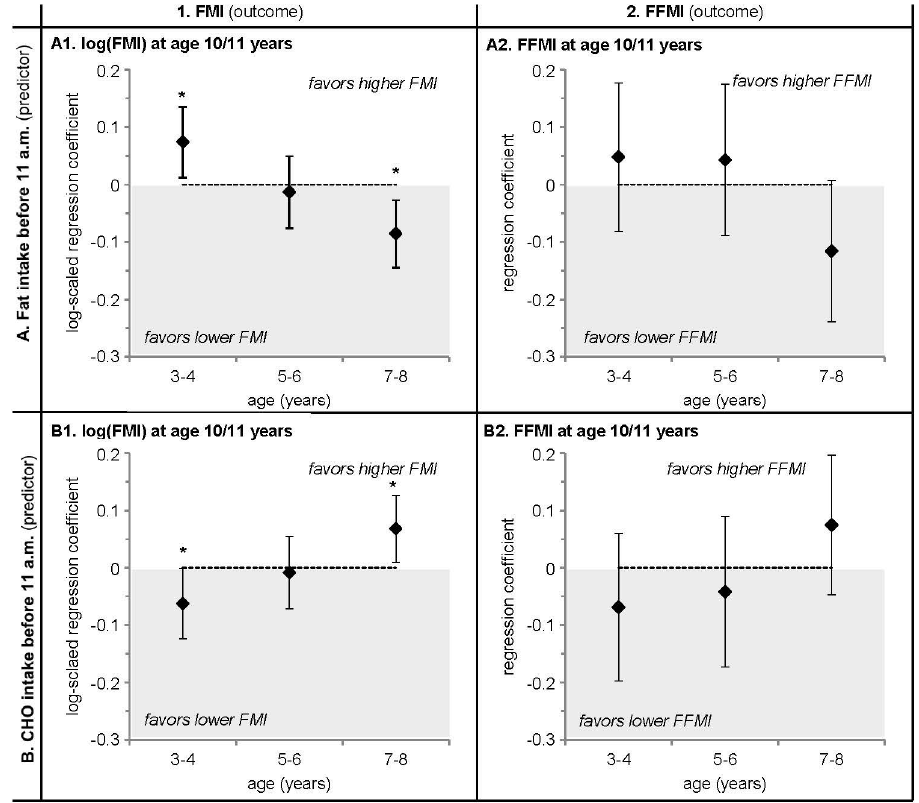
Figure 1. Life ‐ course plots of multivariable linear regression analyses with log ‐ transformed FMI (kg/m 2 ) and crude FFMI (kg/m 2 ) in early adolescence at 10/11 years as the outcome and the standardized intake of ( A ) morning fat (% of energy) and ( B ) morning carbohydrate (CHO) (% of energy) as predicting variables. Analyses were adjusted for age at take ‐ off (ATO) and mean standardized daily energy intake (TEI) from 3 to 8 y. Values are regression coefficients (95% CI) from models ran on N = 372 participants of the DONALD study. * p < 0.05. ATO—age at take ‐ off,